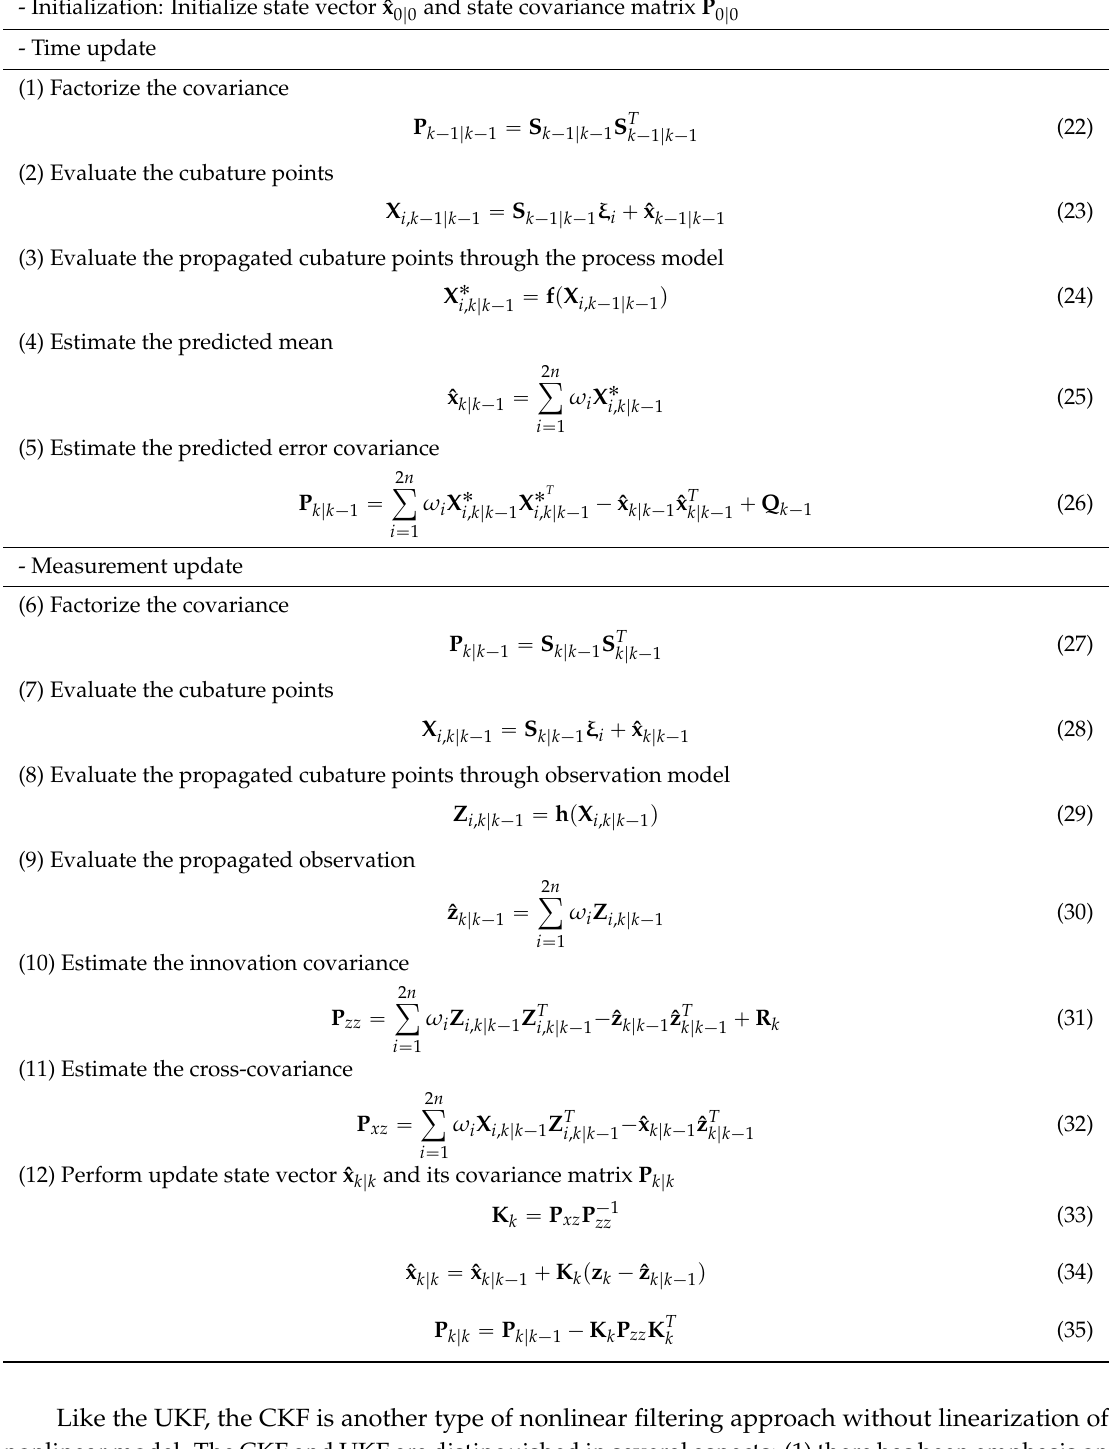
Table 2. Implementation algorithm for the cubature Kalman